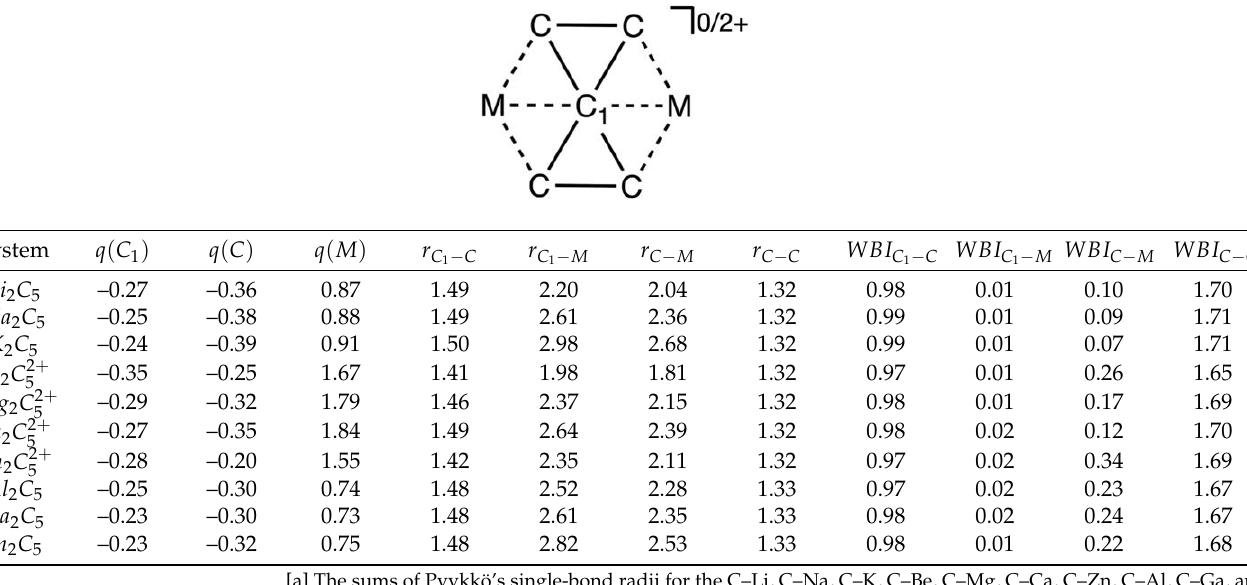
Table 1. Bond lengths (r, Å), natural charges (q, |e|) and Wiberg bond indices (WBI) of the M 2 C 50/2+ (M = Li-K, Be-Ca, Al-In and Zn) computed at the ω b97XD/Def2-TZVP level [a].